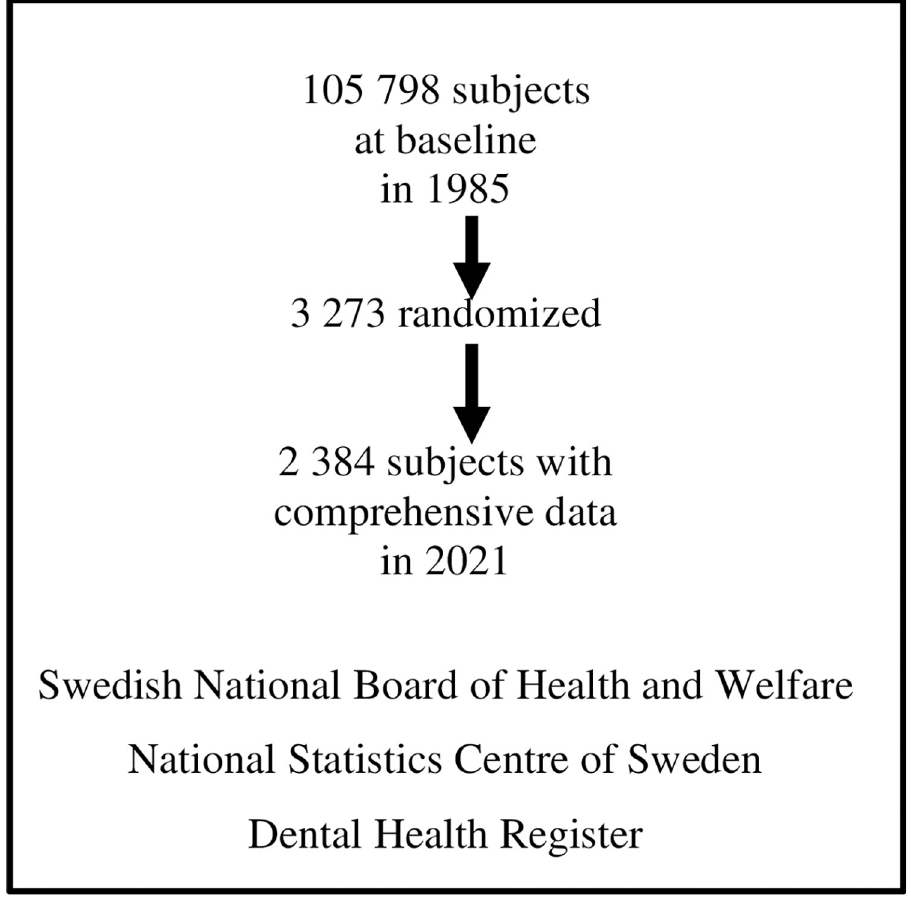
Fig 1. Study profile and the national